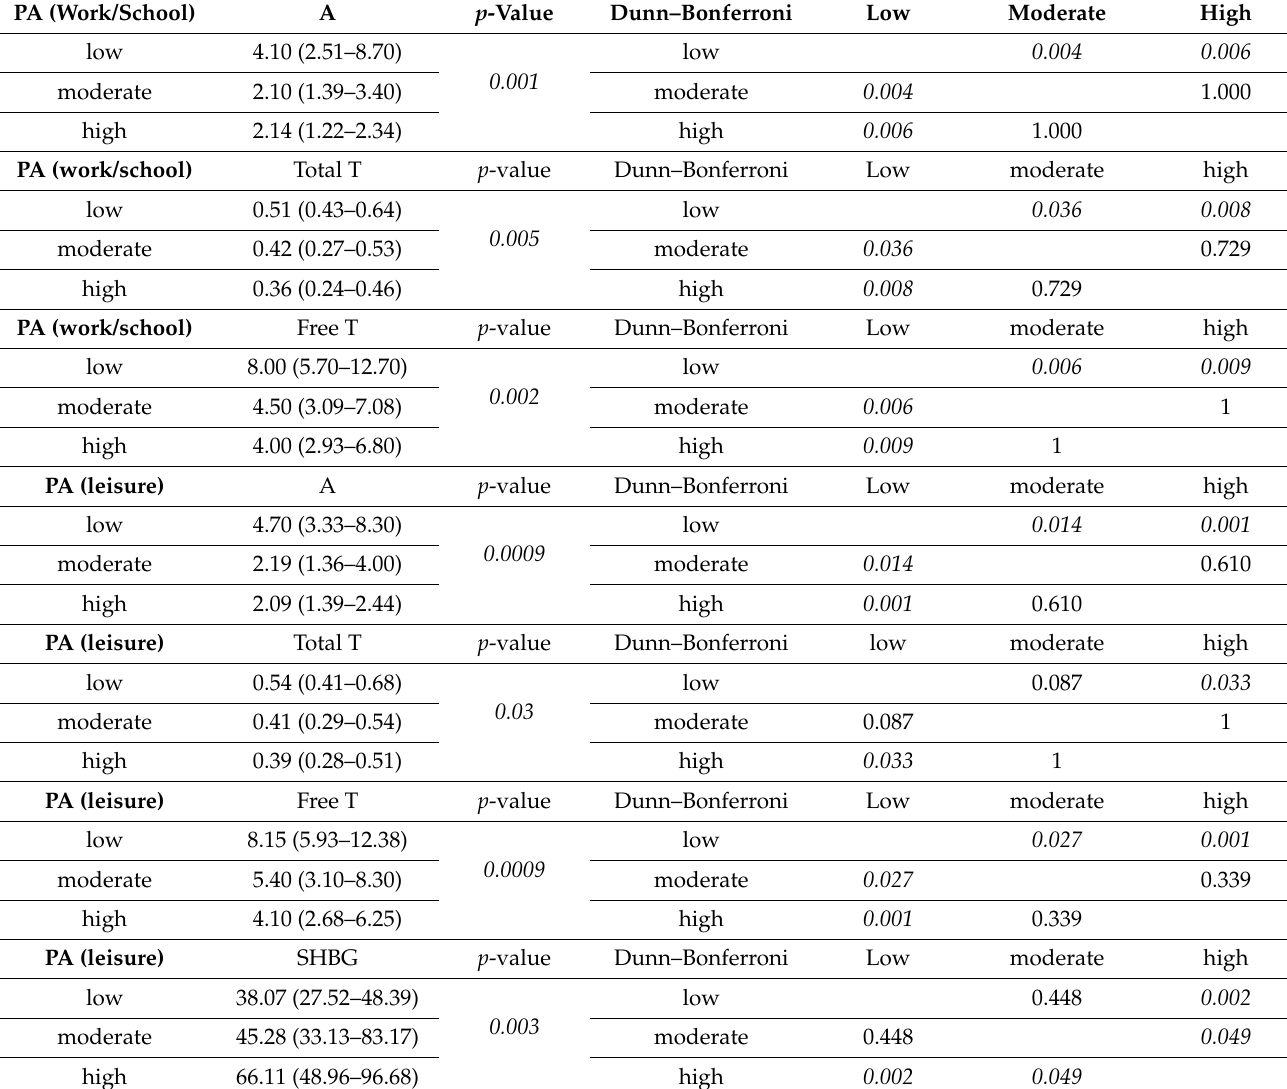
Table 6. Comparison of the concentration of sex hormones depending on the level of PA in the whole study population (PCOS + CONTROL group).